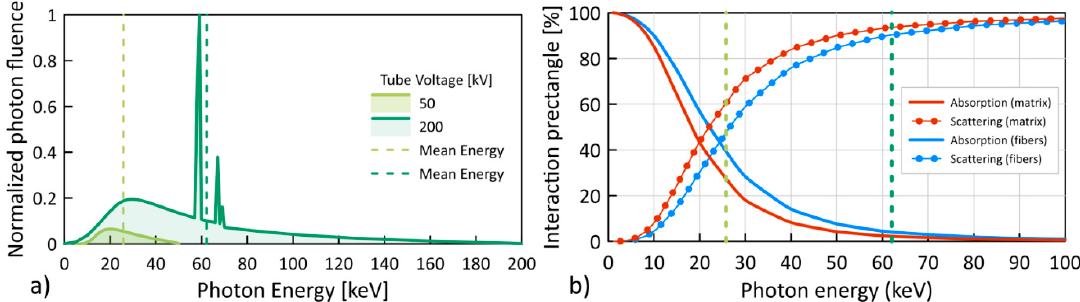
Figure 5. X-ray spectra for tube voltages 50 and 200 kV [52]: ( a , b ) the percentage of absorption (photoelectric effect) and scattering (incoherent scattering) in the PP matrix and aramid fibers [36]. Vertical lines show the mean energies of the spectrum.